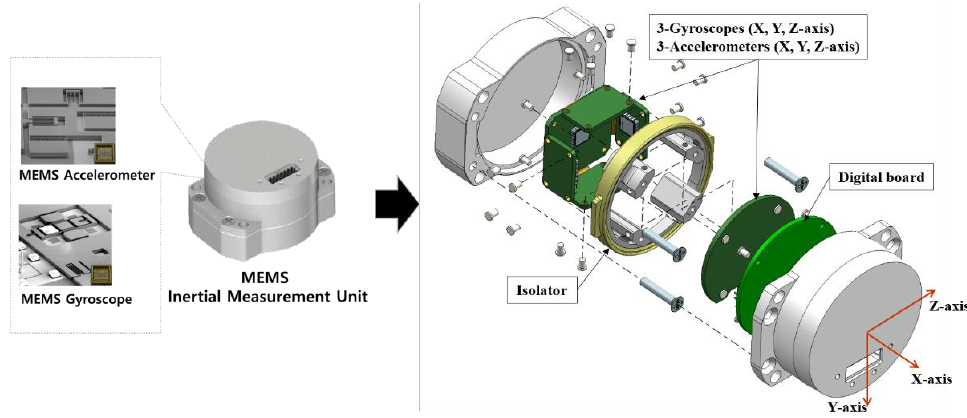
Figure 1. The detailed description of MEMS IMU which was used for pyro-shock